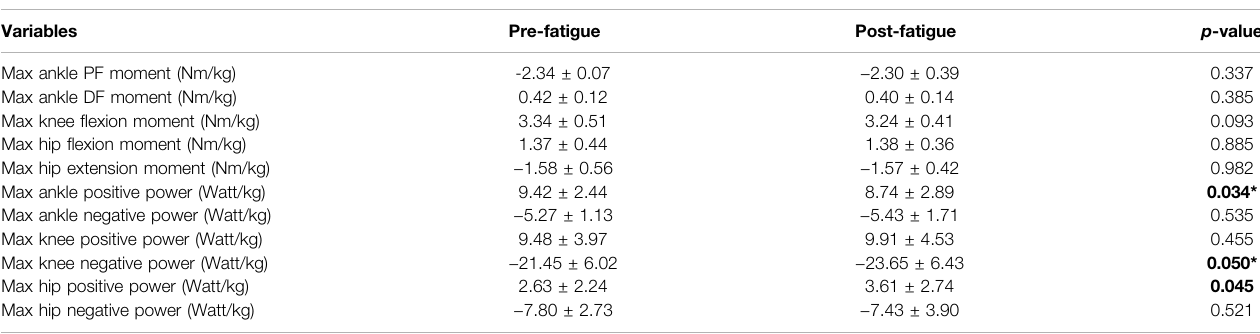
TABLE 4 | Lower extremity joint moment, power pre-fatigue running and post-prolonged fatigue running (x ± SD).